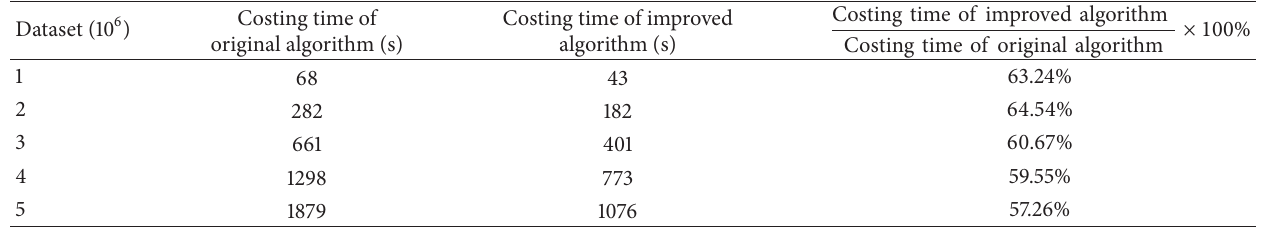
Table 2: Comparison of the SPRINT algorithm and the improved SPRINT algorithm.